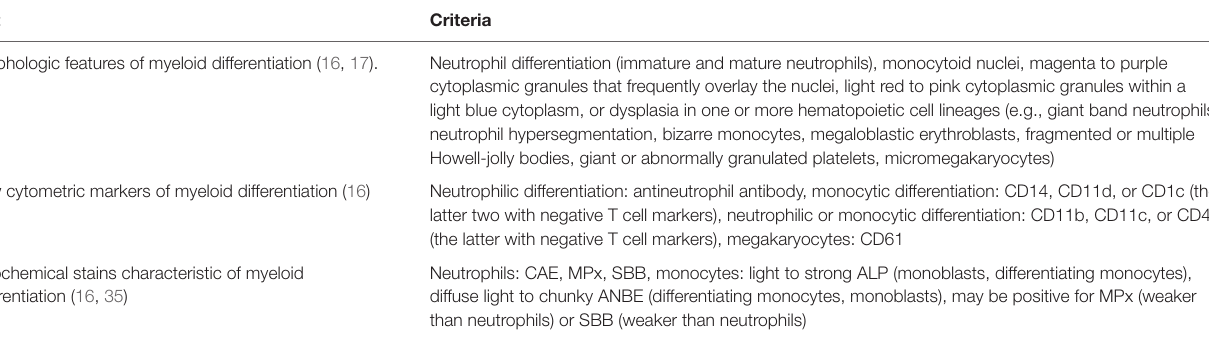
TaBle 1 | criteria used to support myeloid lineage of acute leukemia in 25 dogs. Test criteria Morphologic features of myeloid differentiation (16,